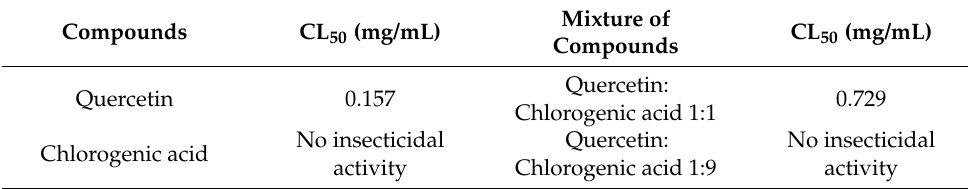
Table 3. Insecticidal activity of quercetin and chlorogenic acid and their mixture in two ratios.